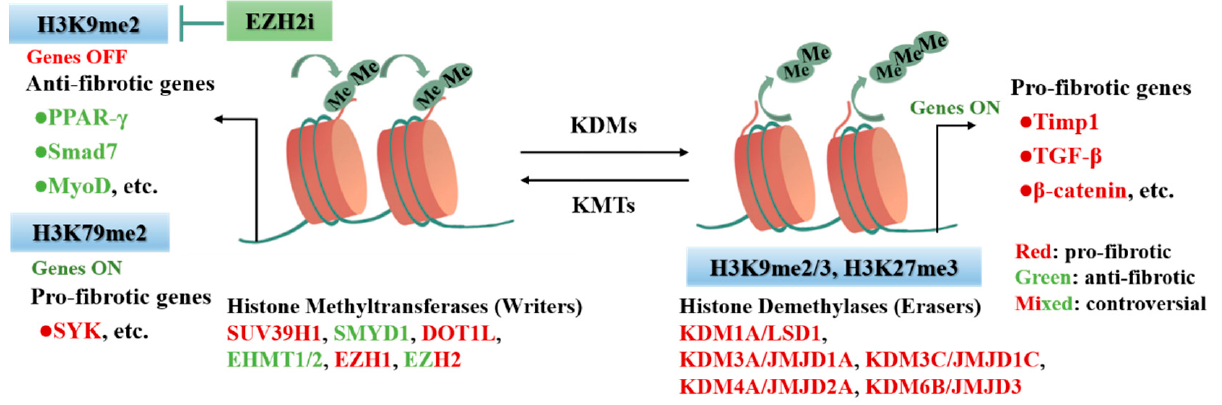
Figure 4. Histone methylation modifications regulate fibrosis-related genes involved in CFs activation and cardiac fibrosis. Histone methylation and demethylation are dynamic and reversible, and histone methylation modification sites and status determine chromosome accessibility and further transcriptional activity of fibrotic genes. Not only do writers KMTs drive H3K9me2, reducing chromatin accessibility and repressing transcription to silence anti-fibrotic genes, but they also drive H3K79me2, increasing chromatin accessibility, activating transcription, and promoting pro-fibrotic gene expression. Conversely, KDMs remove methyl from H3K9me2/3, which increases chromatin accessibility, promotes transcription, and is involved in the activation of pro-fibrotic genes. As shown in the figure, different colors suggest different genes, and epigenetic-modifying enzymes play different roles in cardiac fibrosis. The application of EZH2i can target the alleviation of histone methylation-regulated cardiac